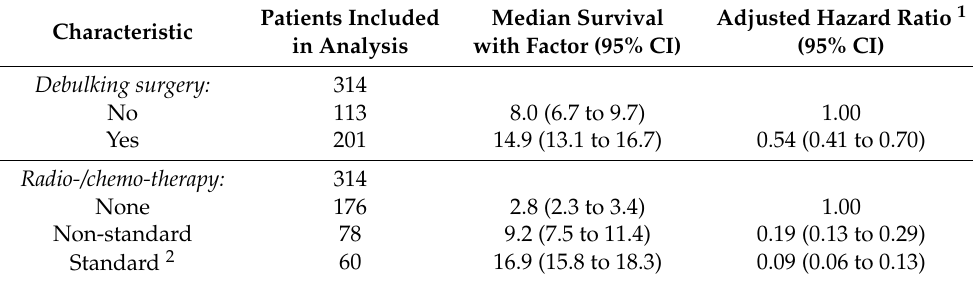
Table 3. Survival characteristics by